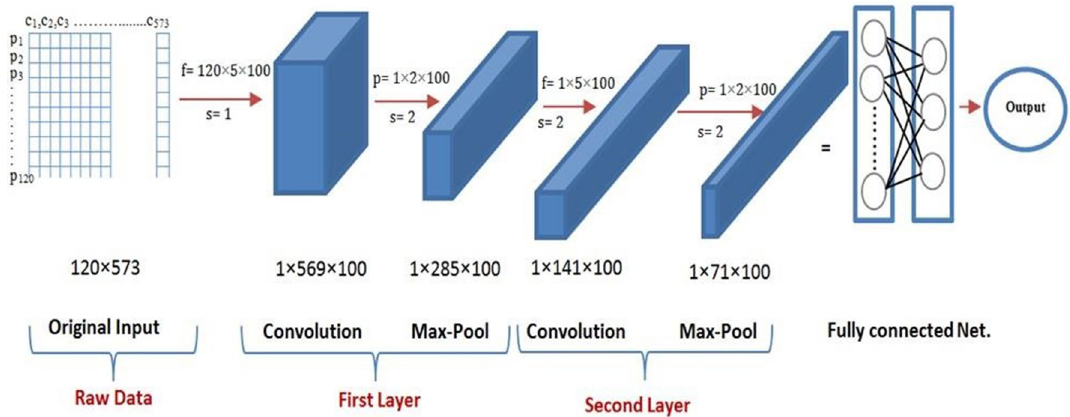
Figure 5. The Architecture of the Proposed CNN, it mainly begins with an original input matrix represents the essential oils data. The internal network schema based on two layers of convolution and pooling. The output of these layers feeds a fully connected feed forward neural network that uses a sigmoid activation function to find the appropriate output.